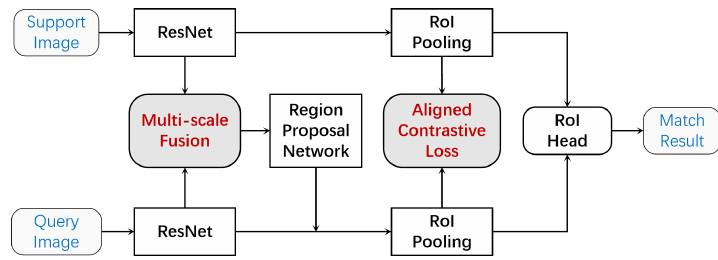
Figure 1. The overall